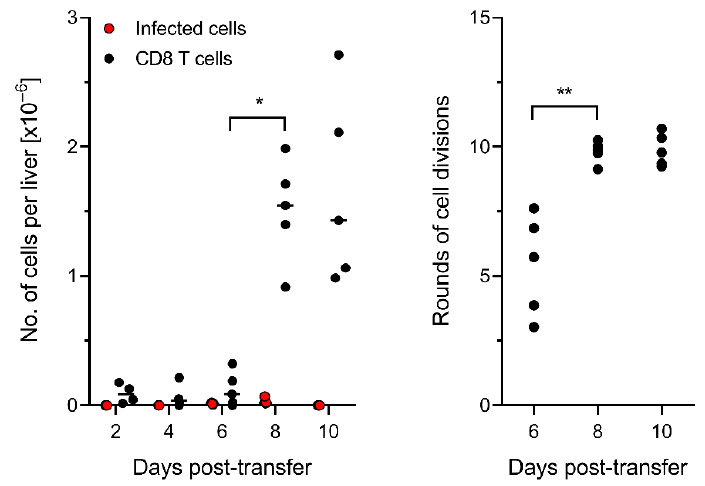
Figure 6. Extensive expansion of memory CD8 T cells in transfer recipients. ( Left panel ) for the indicated times after CD8 ‐ AT, infected IE1 + cells (filled red circles) and tissue ‐ infiltrating CD8 T cells (filled black circles) were counted in representative 2C ‐ IHC ‐ stained liver tissue sections, and the absolute numbers of infected cells and CD8 T cells present in the whole liver were calculated by extrapolation. Symbols represent data of individual AT recipients. Median values are marked. ( Right panel ) calculated numbers of CD8 T ‐ cell divisions based on initially transferred ~1600 viral epitope ‐ specific cells. Symbols represent values for individual AT recipients. Median values are marked. As not all transferred cells home to the liver, the number of cell divisions represents a minimum estimate. Significant with p < 0.05 (*), calculated for log ‐ transformed data. Significant with p < 0.01 (**), calculated for linear data. Student’s t ‐ test with Welch’s correction of unequal variance. The data must be viewed as representing minimum estimates, as not all progeny of transferred CD8 T cells infiltrate the infected liver but infiltrate other infected organs as well. However, this has little influence on the overall conclusion, as every halving of the number of liver ‐ infiltrating CD8 T cells would correspond to an underestimation by just one cell division.